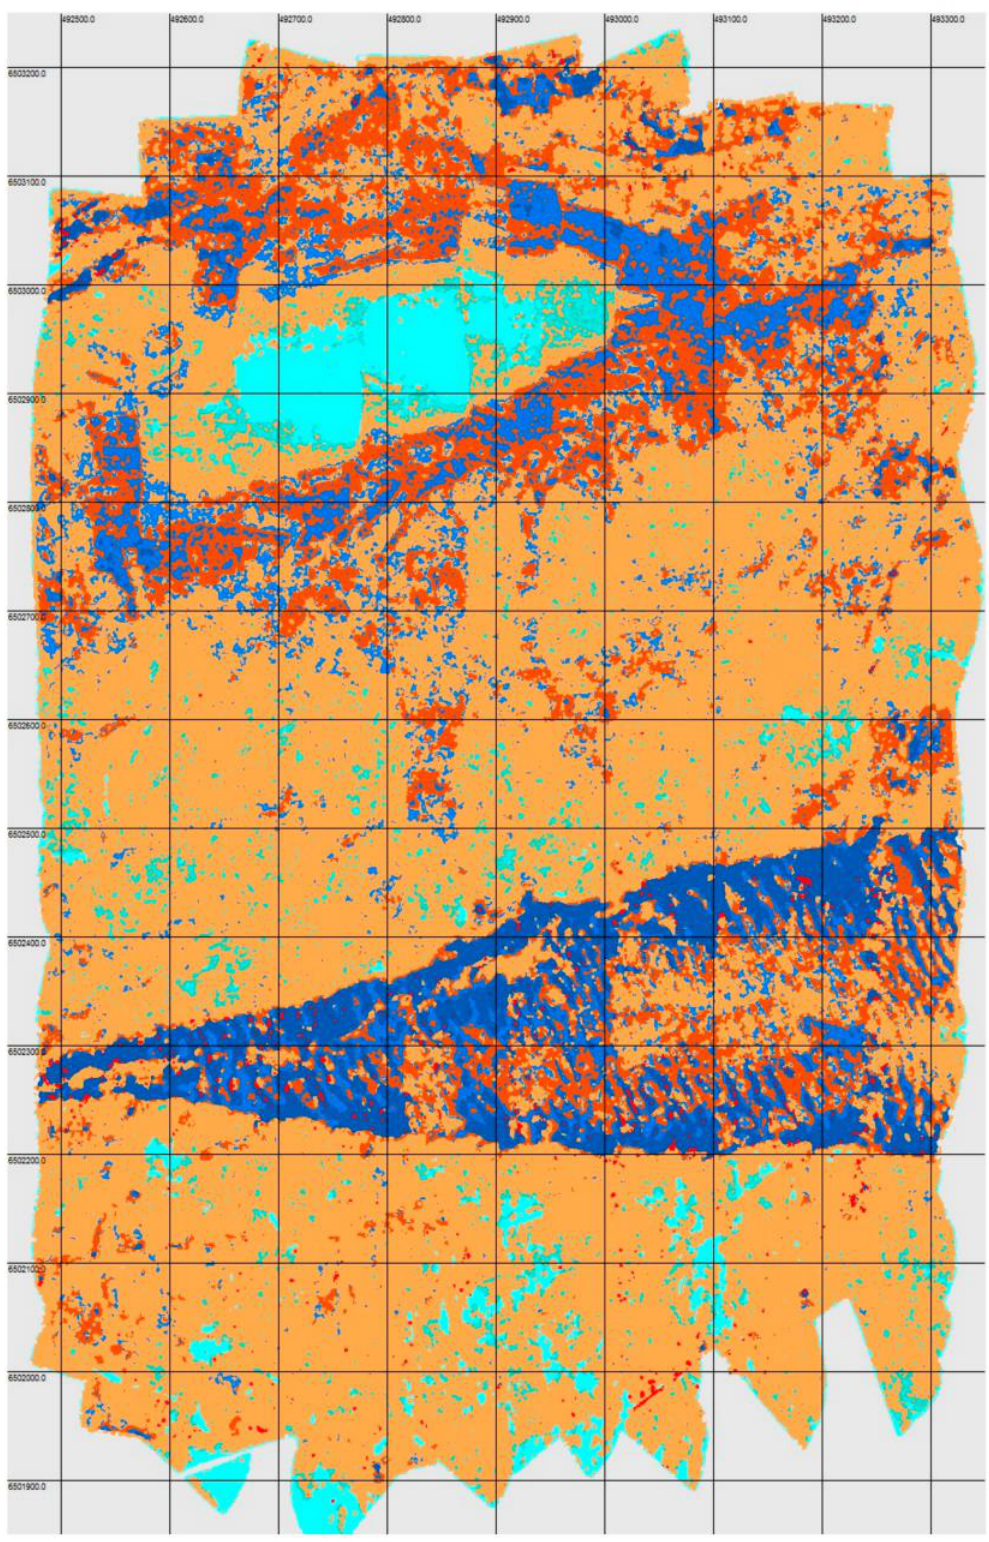
Figure 7. Inner Sound, Pentland Firth. A user-supervised texture-mapped image for the mid-frequency 256 kHz image shown in Figure 6 generated using (Kongsberg) GeoTexture software. The grid lines are at 100 metre intervals. The legend for the figure is given in Table